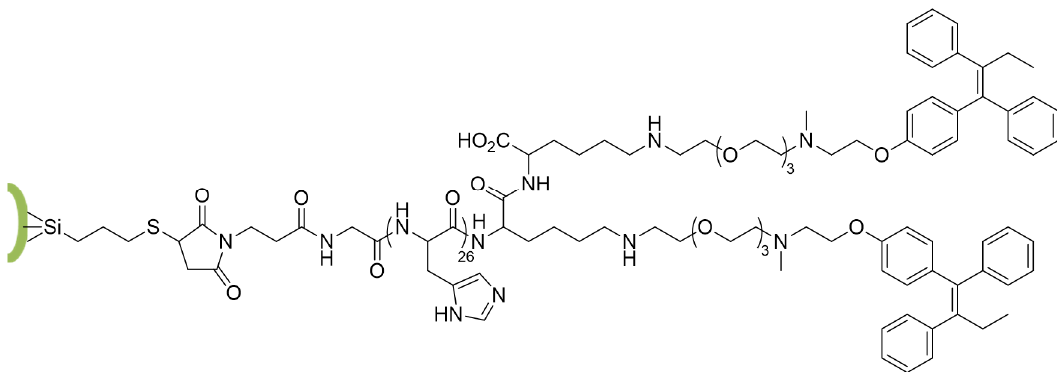
Figure 5. Structure of MSN-PLH-TAM.